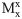
Top: Total, active, and passive force—length relations. Superimposed on the total stress curve are, for a muscle length of L/L0 = 1.5, the half-sarcomere lengths predicted by models Mxx and MFv (red crosses), and models MATI and MATIFv (blue dot). The value predicted by models MATI and MATIFv coincides with the theoretically predicted stress—stretch value. Bottom: Histogram of half-sarcomere lengths in models Mxx and MFv (red), and models MATI and MATIFv(blue, scaled for readability). Under conditions of steady state (after 2.5 s), the results of models Mxx and MFv, as well as those of models MATI and MATIFv, coincide.